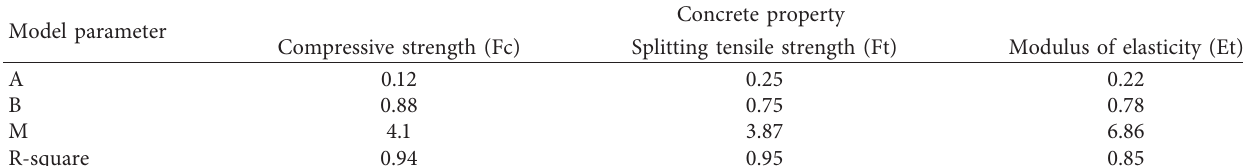
Table 6: Parameter of reduction function for HSRC specimens at 28